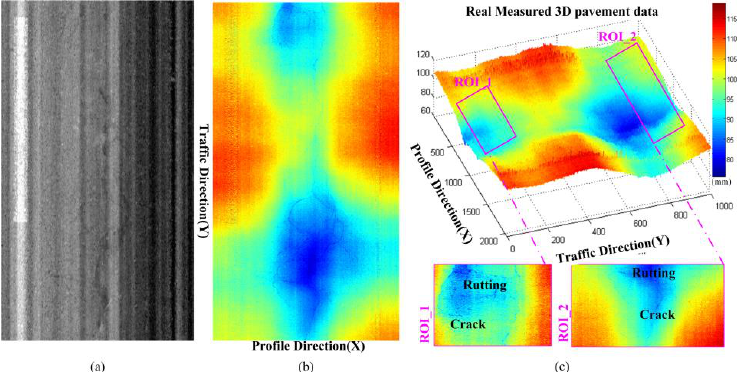
Figure 3. The 2D pavement image and corresponding 3D laser scanning data (with cracks, road markings, and rutting), ( a ) 2D pavement image, ( b ) real measured 3D laser scanning data, ( c ) 3D laser scanning data and some local ROI illustrations.